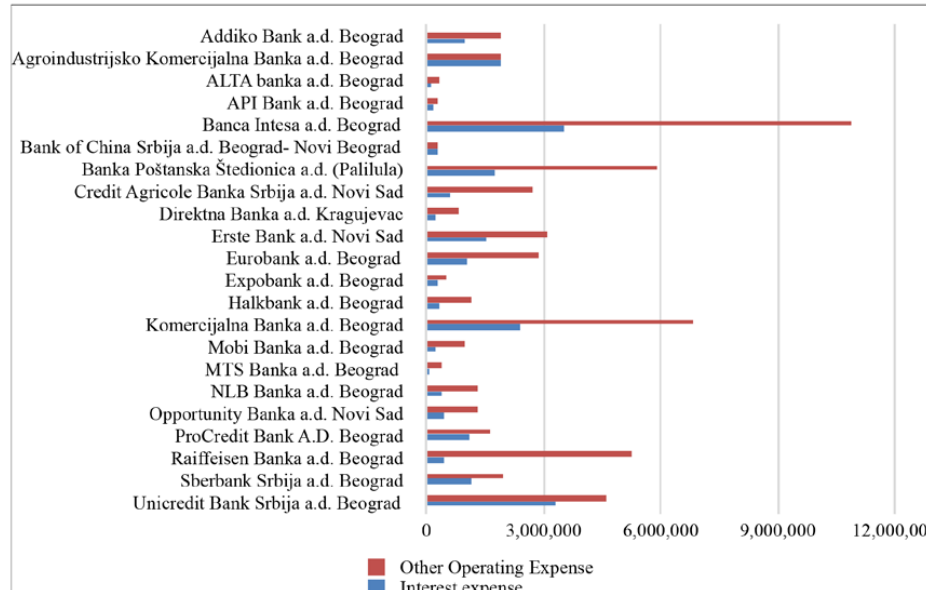
Figure A5. Mean for the inputs for each bank.